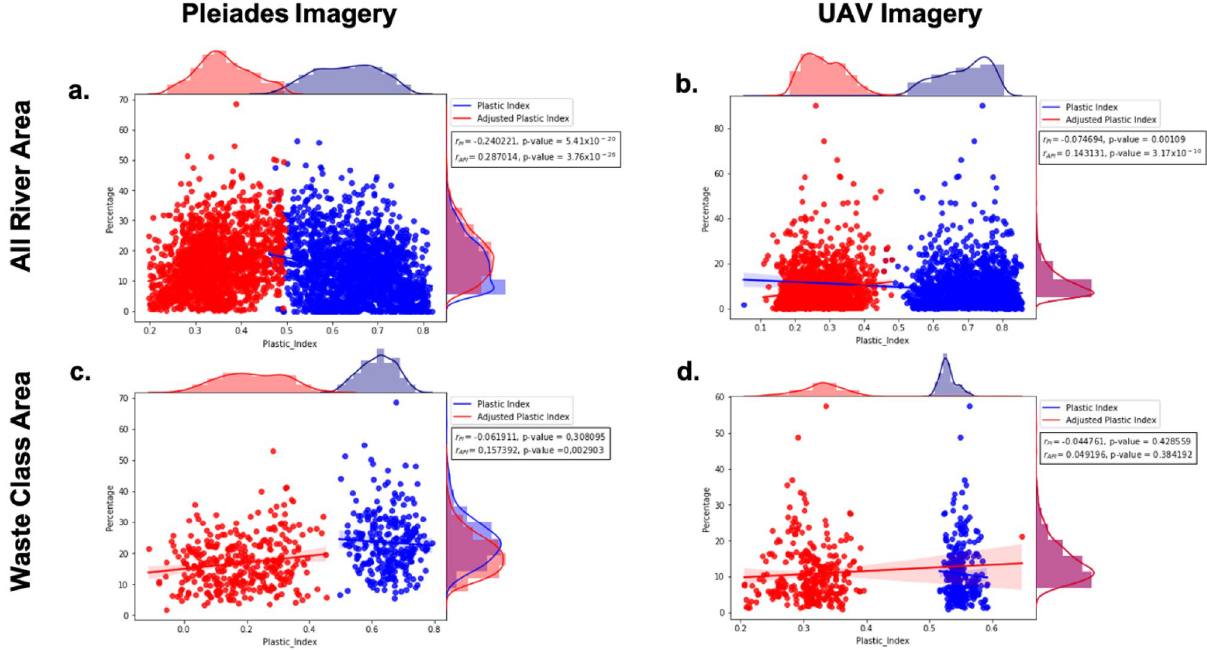
Figure 9. Scatterplot comparison between the percentage of plastic waste from Pleiades imagery and UAV imagery with plastic index (PI) and adjusted plastic index (API) of Sentinel-2: (a) comparison with Pleiades imagery for the entire river area, (b) comparison with UAV imagery in all river area, (c) comparison with Pleiades imagery in Sentinel-2 waste class area, (d) comparison with UAV imagery in Sentinel waste class area.